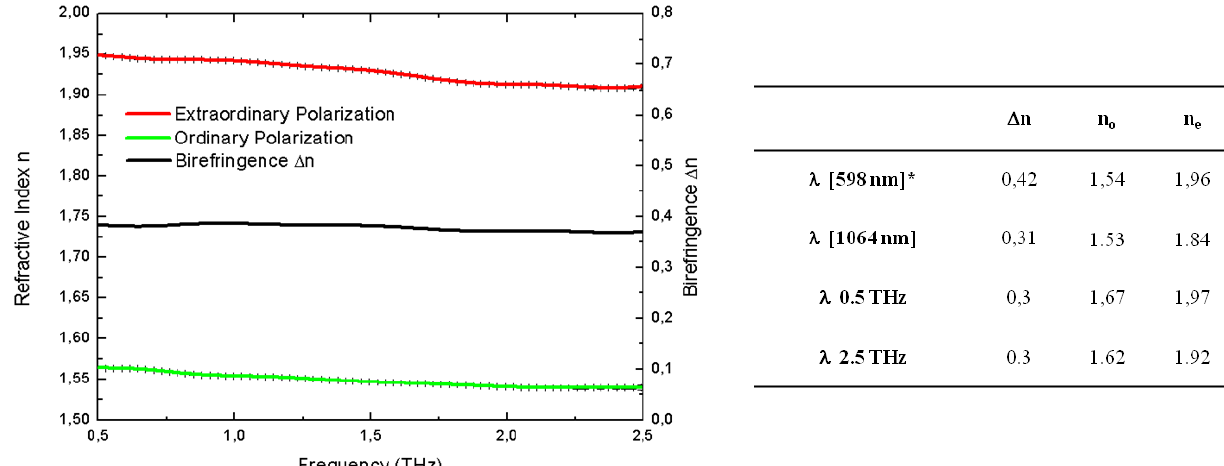
Figure 14. Comparison of refractive indices for mixture 1825 at visible, infrared and THz range.